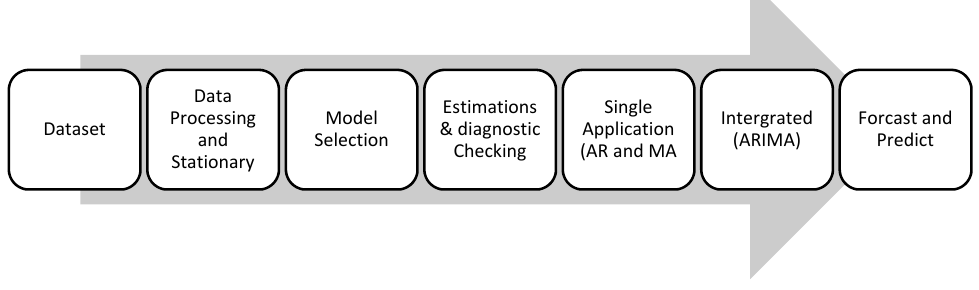
Figure 2. Steps for ARIMA model selection.